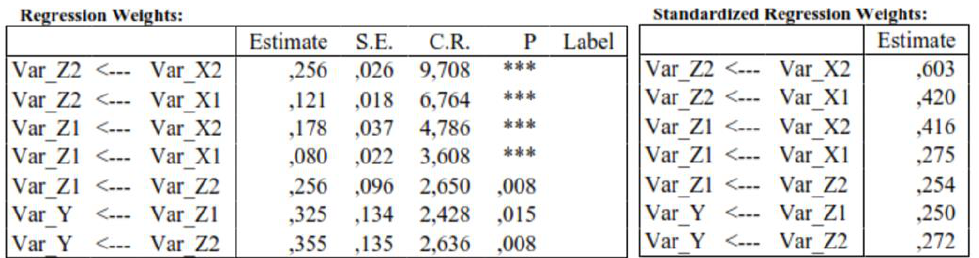
Table 1: Regression Weight & Standardized Reg. Weight